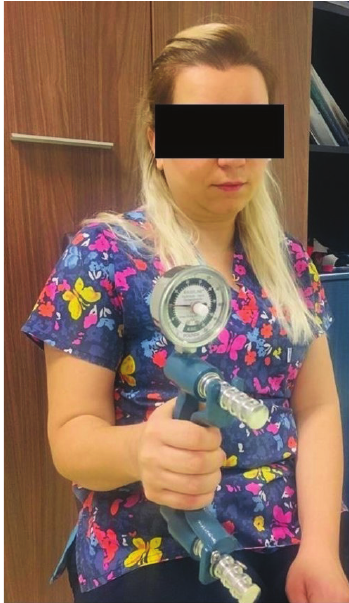
FIGURE 1. Measurement of hand-grip